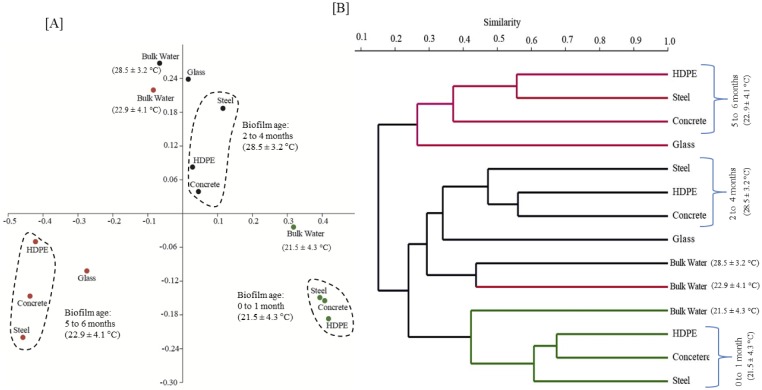
A similarity analysis (at 97% sequences similarity) of bulk water and biofilm samples (obtained from MRD & KIWA) based on Bray-Curtis similarity index: [A] Principal coordinates analysis (PCoA); [B] Cluster analysis.